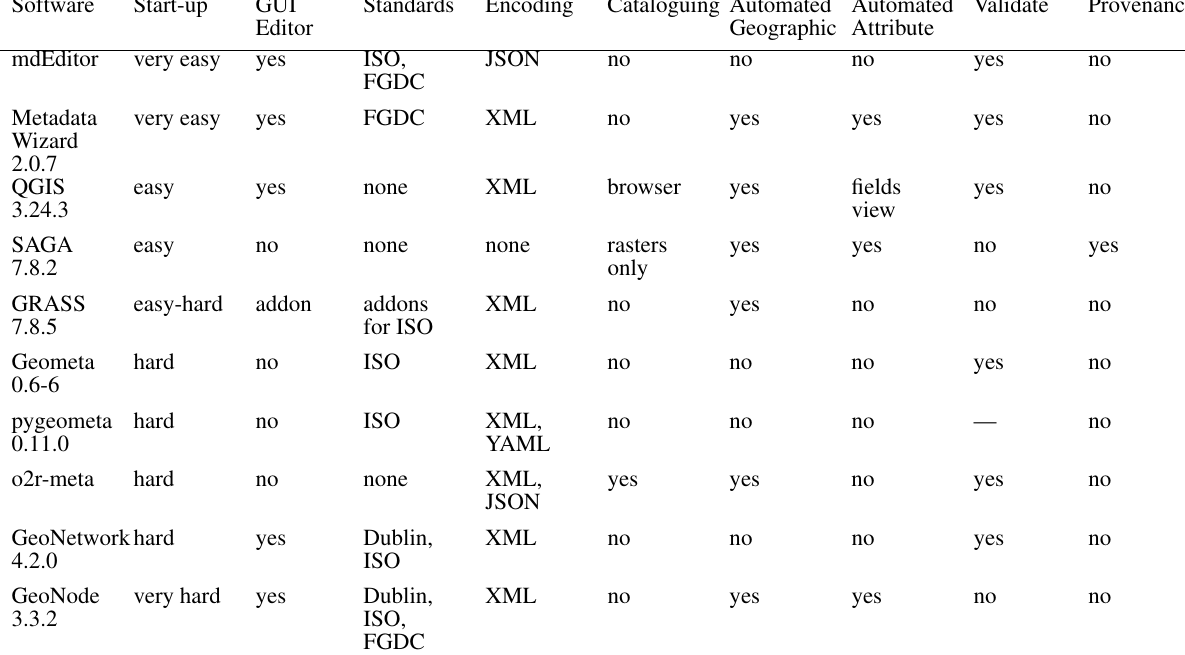
Table 2. Spatial metadata software